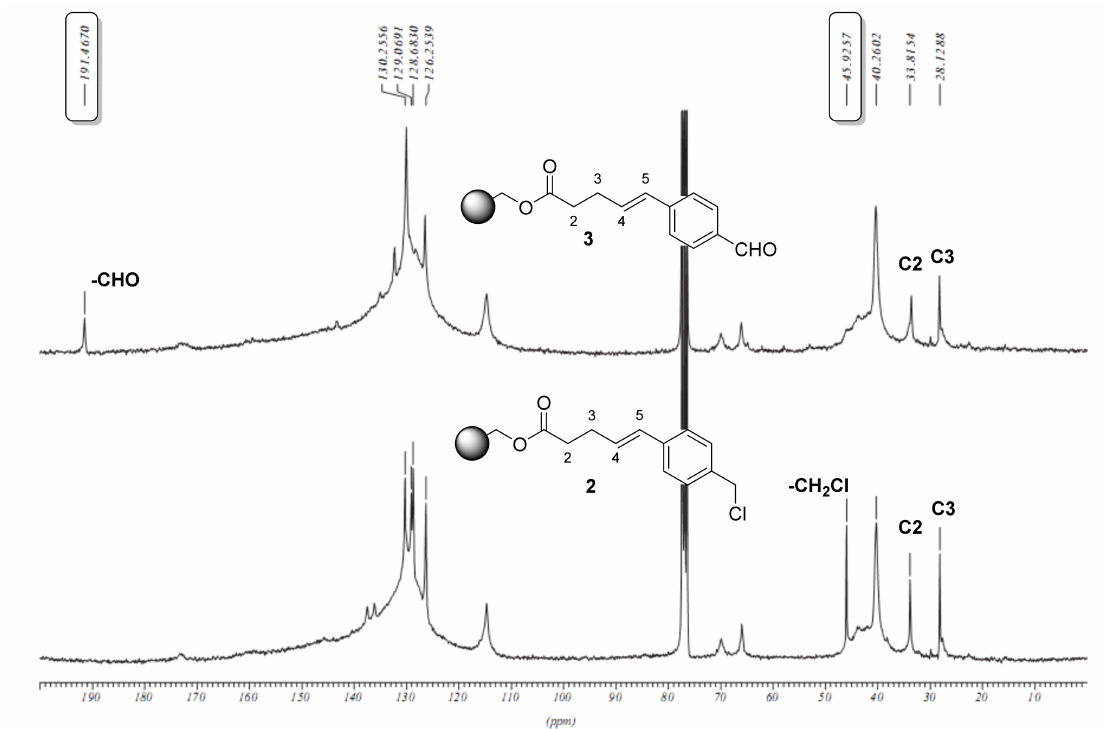
Figure 1. 13 C gel-phase NMR of compounds 2 and 3